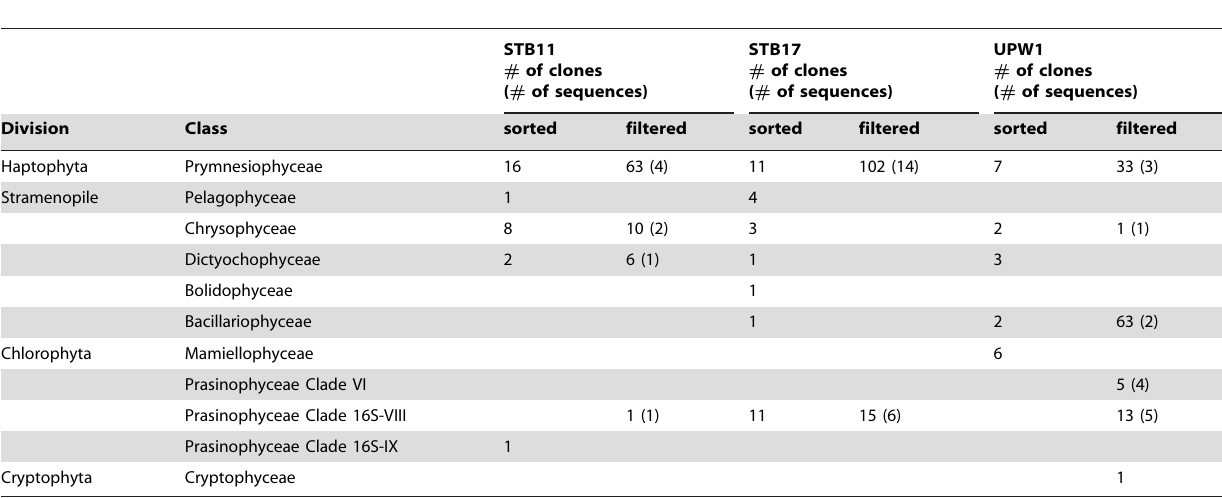
Table 2. Comparison of photosynthetic picoeukaryote community structure revealed from sorted samples (this study) vs . filtered samples [9], using primer set PLA491F/OXY1313R.